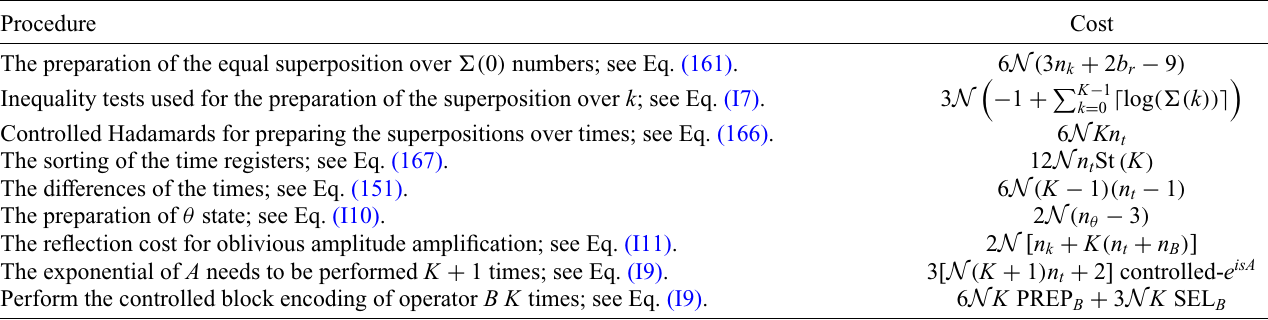
TABLE VIII. The costs of the interaction-picture algorithm for time evolution of a general Hamiltonian. The costs are Toffoli costs unless otherwise specified (the last two